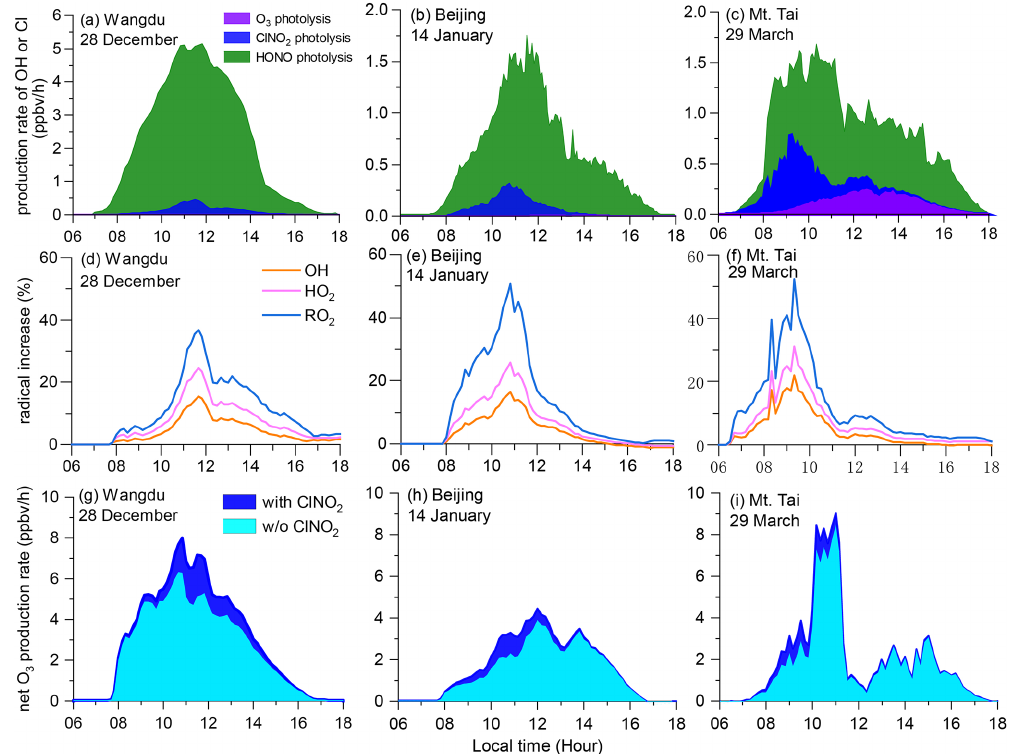
Figure 8. The impact of ClNO 2 photolysis on atmospheric oxidation during daytime-ClNO 2 episodes: (a) primary radical production from the photolysis of O 3 , ClNO 2 , and HONO; (b) percentage increase in OH, HO 2 , and RO 2 due to ClNO 2 photolysis (Sect. 2.5); and (c) enhancement of net O 3 production rates due to ClNO 2